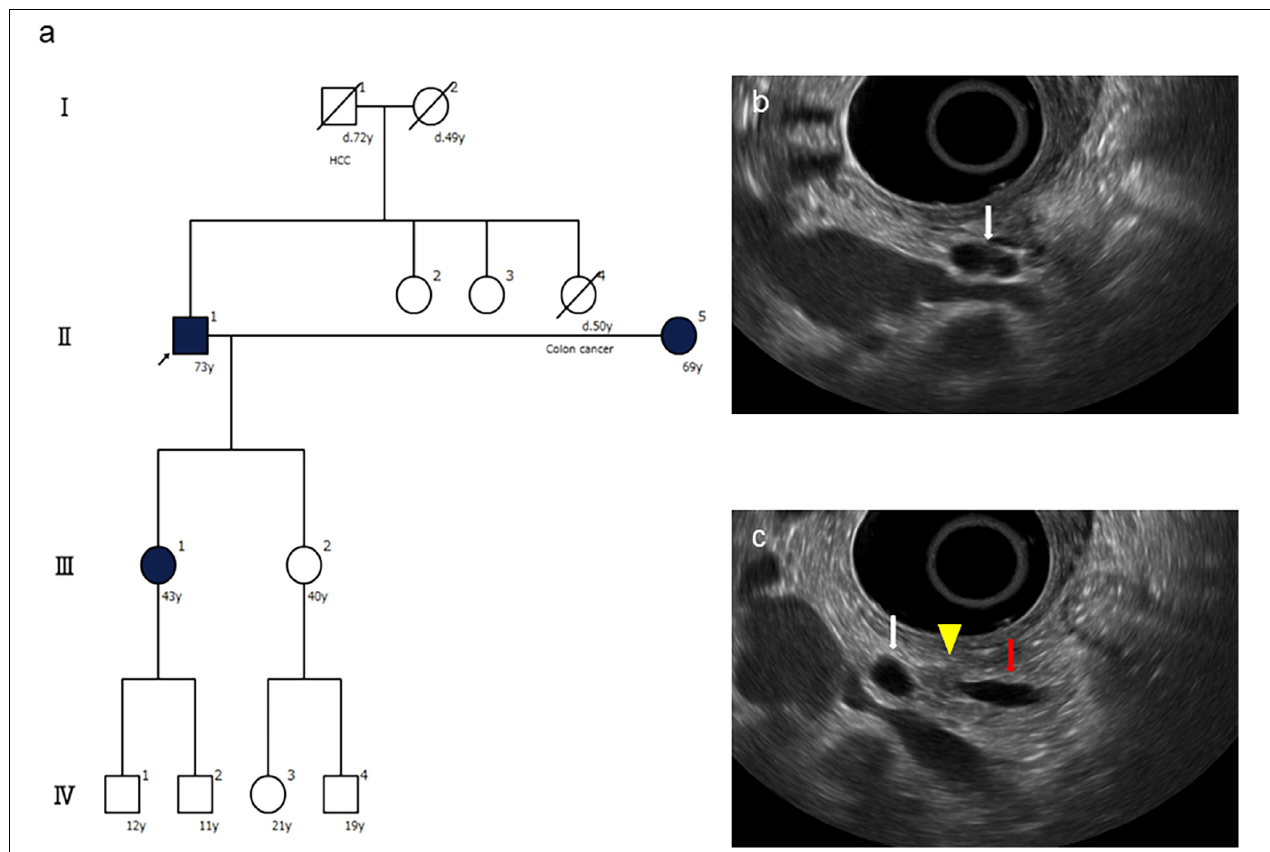
FIGURE 3 | Family tree and endoscopic ultrasound (EUS) findings of the presented case. (a) The family tree shows one affected first-degree relative with pancreatic cancer (PC), an high-risk individual (HRI) (arrow) who was diagnosed with PC by this screening. (b) FR-EUS shows a cystic lesion (white arrow) in the pancreatic body. (c) FR-EUS shows a hypoechoic mass (arrowhead) in the pancreatic body between a pancreatic cyst (white arrow) and dilated MPD (red